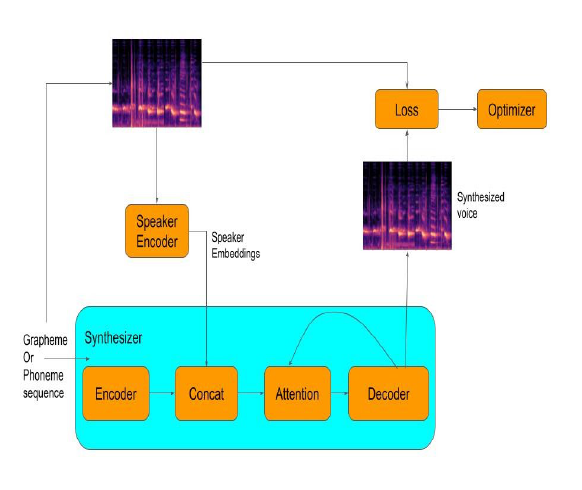
Figure 3. Synthesizer Training